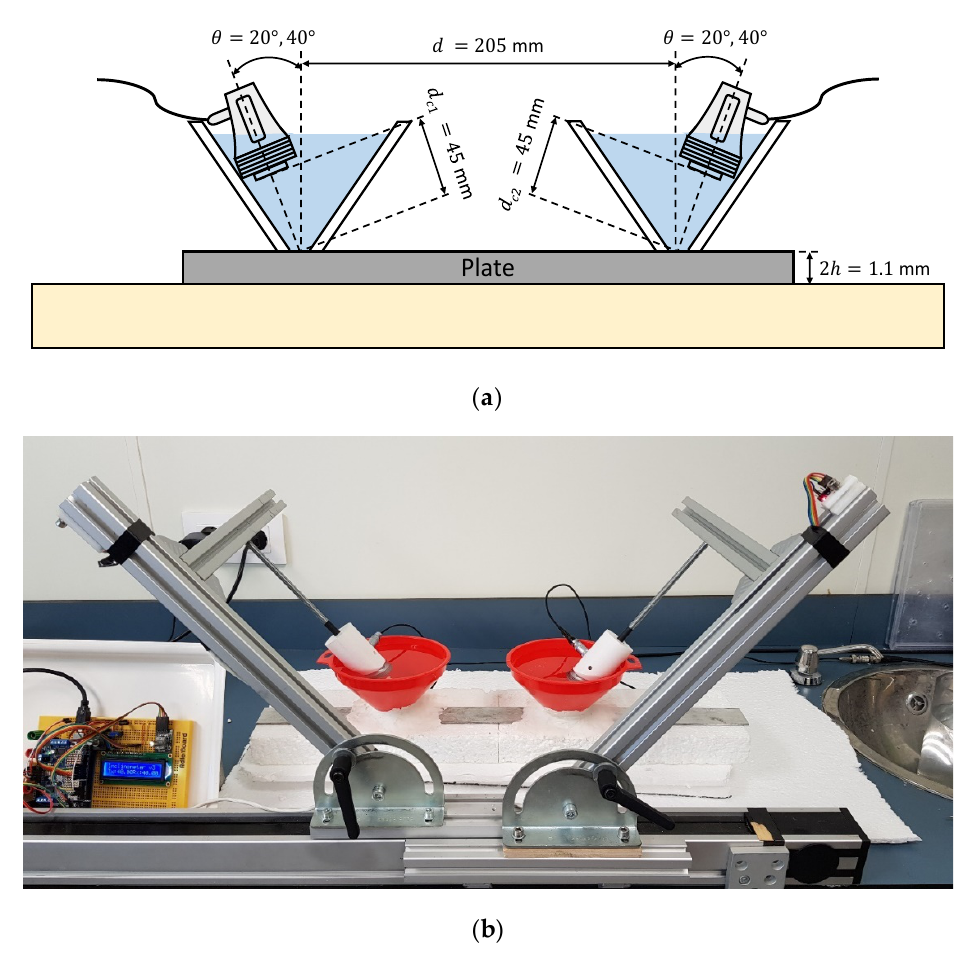
Figure 11. Conical containers setup to measure the stainless-steel plate: ( a ) Schematic; ( b ) Photograph. The angles chosen, as in the previous case, were 20° and 40°, for the same frequency range (1–3 MHz). It was expected to excite the same modes, S 0 with 20° and A 0 with 40°, since the coupling medium was not modified and, therefore, the same angle curves from Figure 9 could be used.